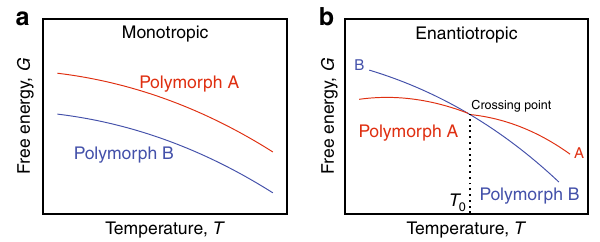
Fig. 1 Schematic representation of the two types of polymorphs. a Monotropic and b enantiotropic polymorphs, where T 0 denotes the transition temperature in enantiotropic polymorphs (e.g., sulfur), where below the melting point one polymorph can reversibly transition to the other polymorph. For monotropic polymorphs (e.g., glyceryl stearates), this transition is not possible